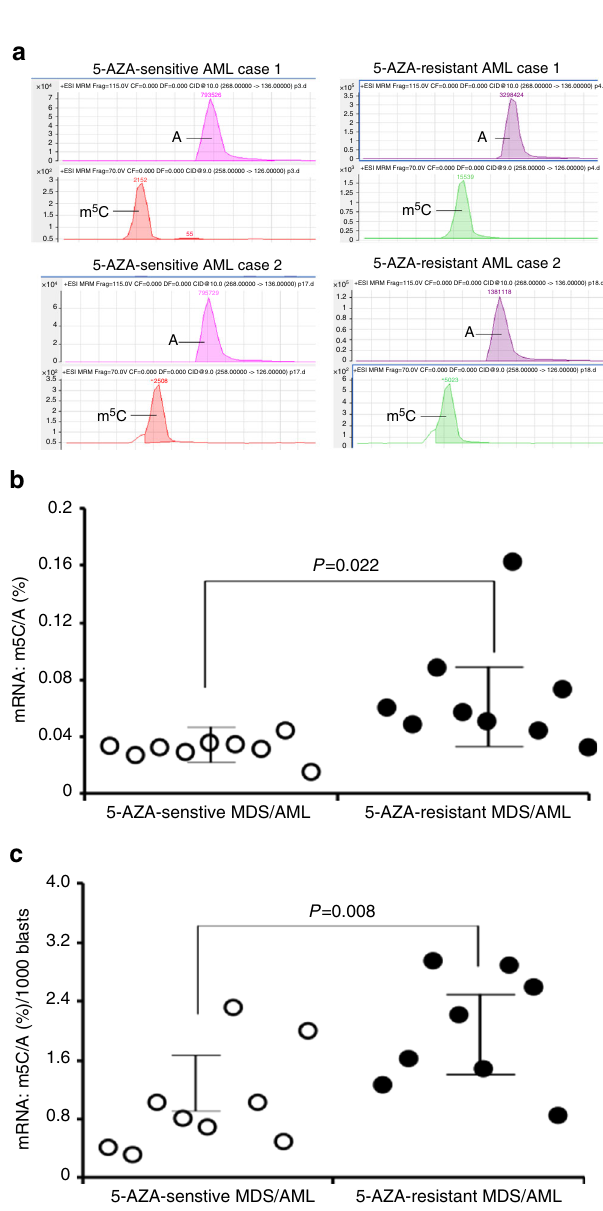
Fig. 9 Mass spectrometric analysis of mRNA:m 5 C in clinical 5-AZA- sensitive and 5-AZA-resistant AML/MDS specimens. a Representative mass spectra of the mRMA:m 5 C and adenosine peaks using the Ficoll- Paque ™ PLUS-puri fi ed mononuclear bone marrow cells from 5-AZA- sensitive and 5-resistant AML and MDS specimens. b Quantitative measurement of the m 5 C/A ratios in 5-AZA-sensitive and 5-AZA-resistant clinical AML/MDS bone marrow cells. c Comparison of the manual blast count-normalized mRNA:m 5 C levels in 5-AZA-sensitive vs. 5-AZA- resistant clinical AML/MDS bone marrow